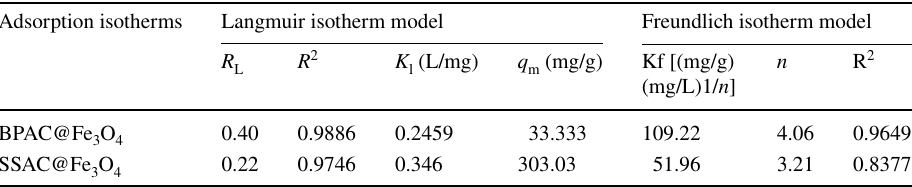
Table 3 Adsorption isotherm data for the removal of BB41 dye by adsorption process